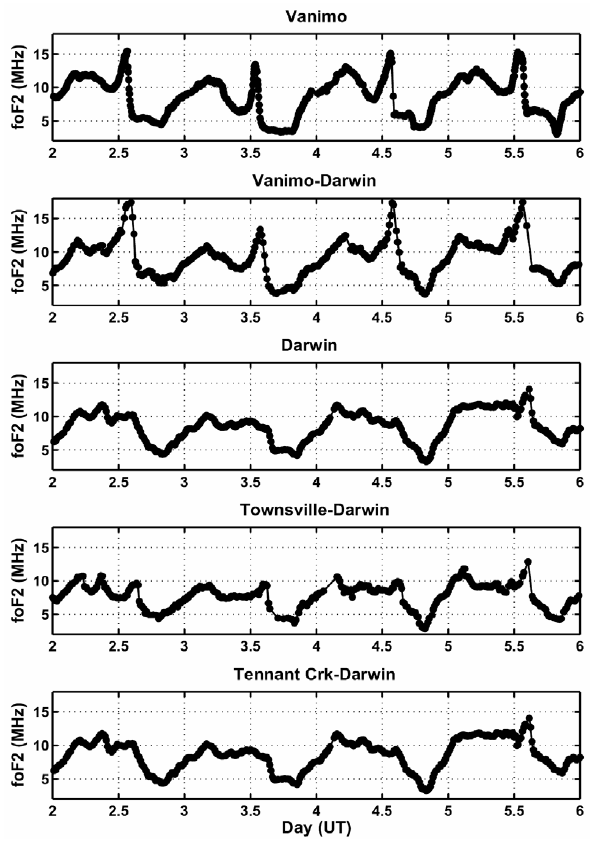
Fig.2. Diurnal variations in foF2 at ionospheric reflection points of increasing Fig. 2. Diurnal variations in fo F2 at ionospheric reflection points of latitude observed over the period 2-6 November 1997. increasing latitude observed over the period 2–6 November 1997.